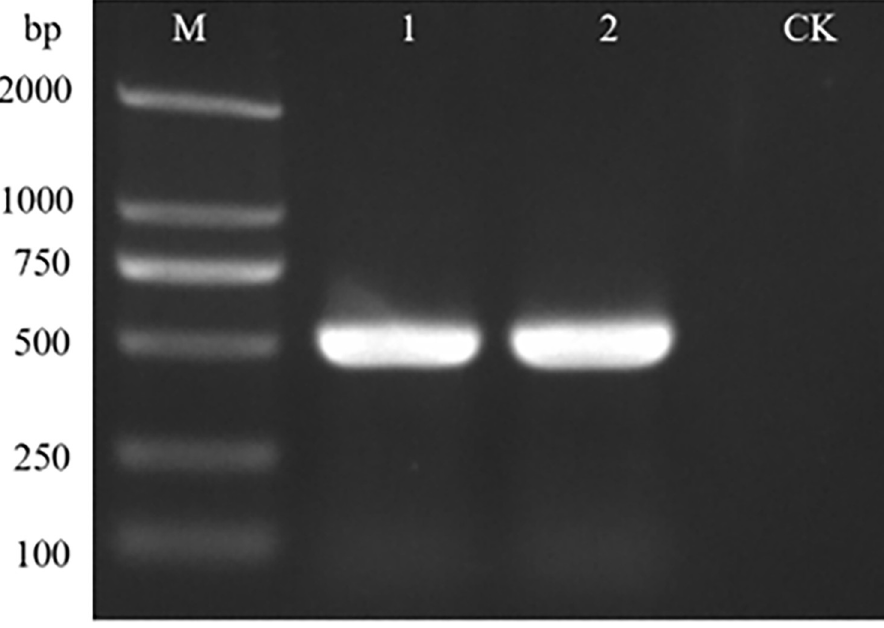
Fig 7. RT-PCR test results of irrigated tobacco. M: Trans2K 1 DNA marker; 1–2: Tobacco samples watered with water samples containing TMV; CK: Negative control.